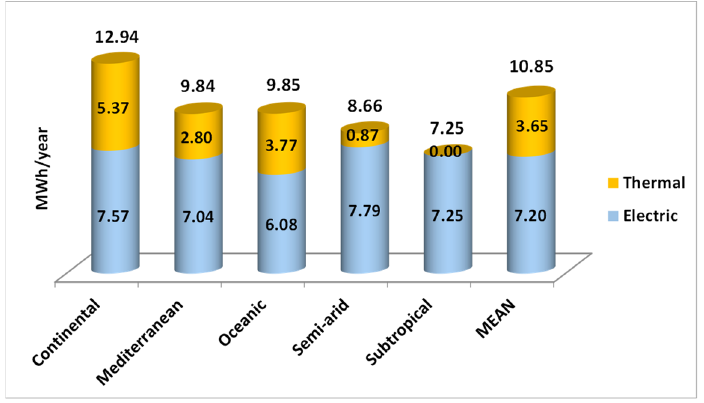
Figure 3. Thermal, electric, and total energy consumption per household of each Spanish climate zone.